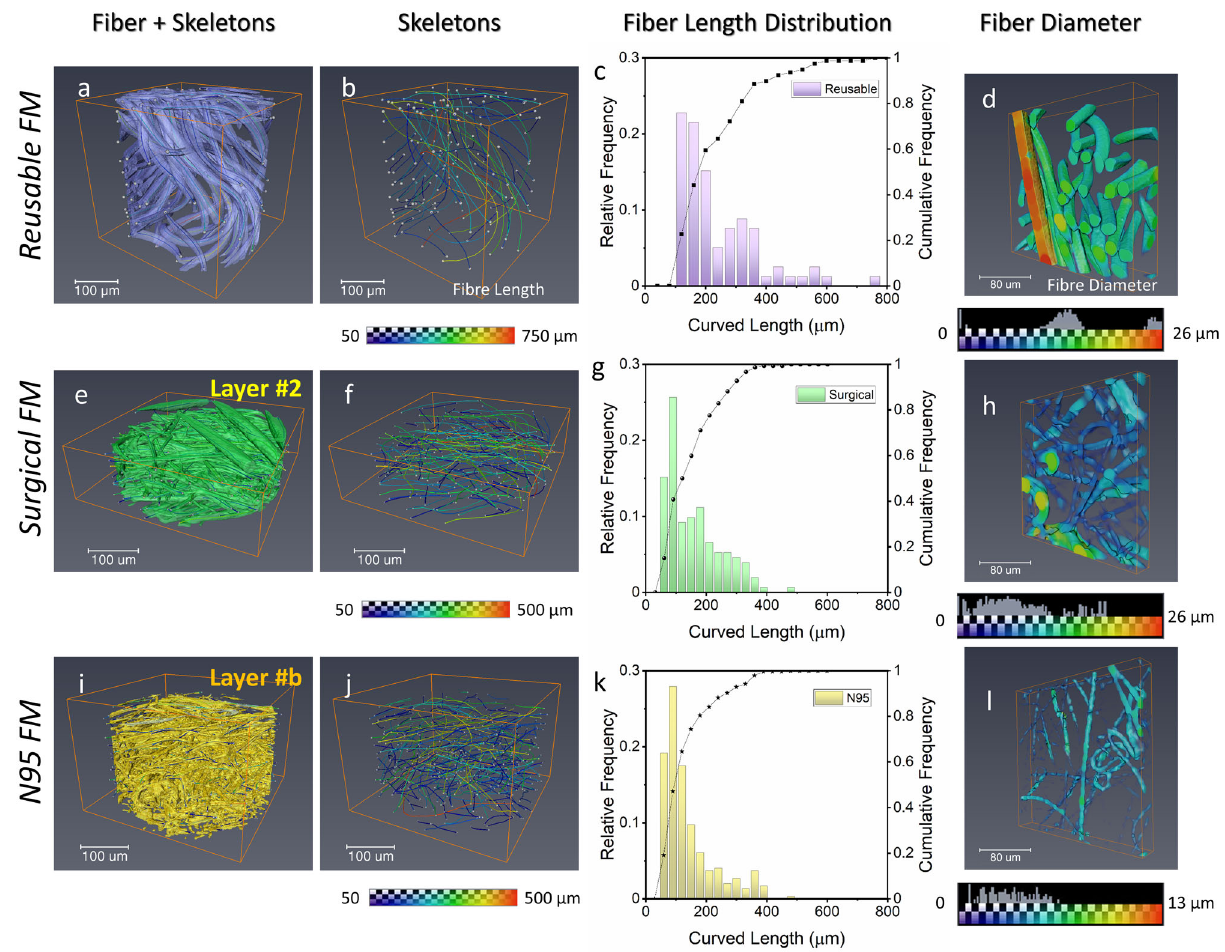
Fig. 3 The quanti fi cation of fi bres (length and diameter) of the three commercial face masks. The interactive fi bre tracing and its correlation algorithms (skeletonizations), and thickness mapping are performed in Avizo to understand face masks microstructure, and performance. a , e , i 3D fi bres are rendered as transparent (70%) with their skeletons inside. b , f , j The skeletons (curved lines) are used to track and represent each individual fi bre. True fi bres are deliberately masked. Skeletons are labelled to different colours (range from 50 to 750 µ m, skeletons shorter than 50 µ m are ignored) according to their length scale. c , g , k The corresponding length distributions of fi bres are quanti fi ed. d , h , l The diameter of fi bres is assigned to multiple colours that scaled is according to the fi bre thickness. It should be noted that the thickness distributions are displayed above the colour bar.